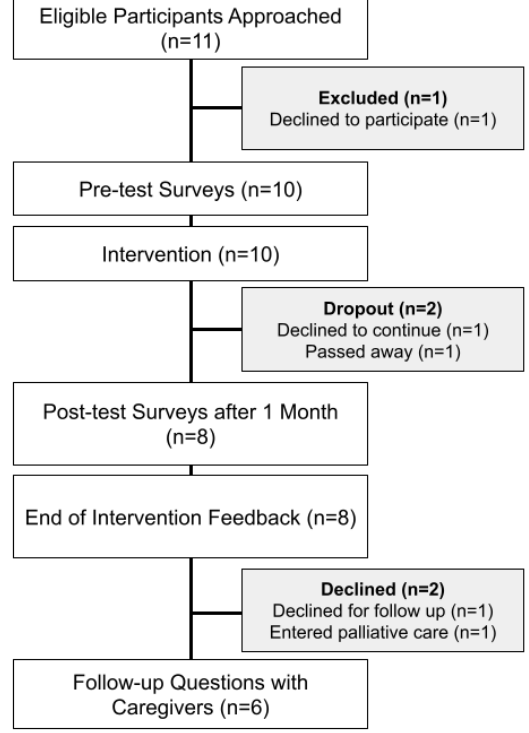
Figure 2. Flow Diagram for Design of Study There are four male participants and four female